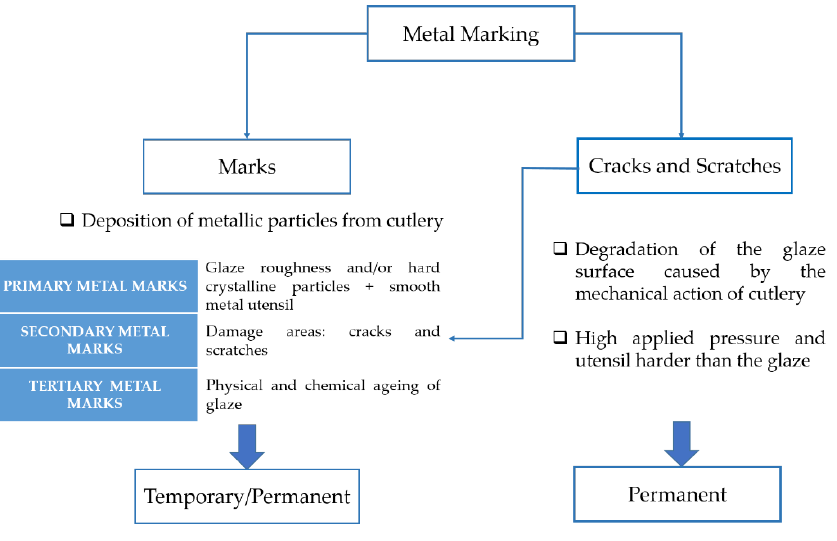
Figure 2. Metal marking definition.